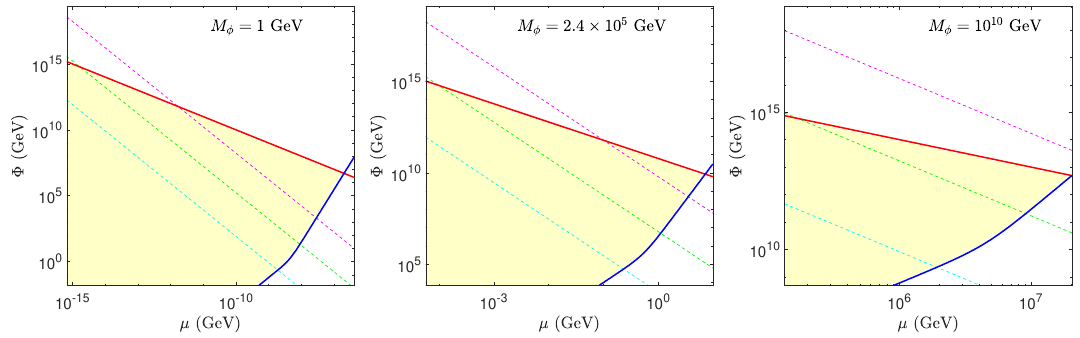
Figure 13. Reheating parameter space for M (cid:30) = 1 GeV (left), M (cid:30) = 2 : 4 (cid:2) 10 5 GeV (center) and M (cid:30) = 10 10 GeV (right). If the in(cid:13)aton amplitude at the end on in(cid:13)ation is in the region above the red line, then the universe undergoes by broad resonance preheating, eq. (B.2). If the in(cid:13)aton amplitude at the end of in(cid:13)ation is in the yellow shaded region, then the e(cid:11)ects of preheating are sub- dominant and the Universe undergoes perturbative reheating. Perturbative reheating ends on the blue line, eq. (B.6). The dotted lines represent constant temperature contours during perturbative reheating calculated using eq. (B.3), T = 10 M (cid:30) (magenta), T = M (cid:30) (green) and T = 0 : 1 M (cid:30)